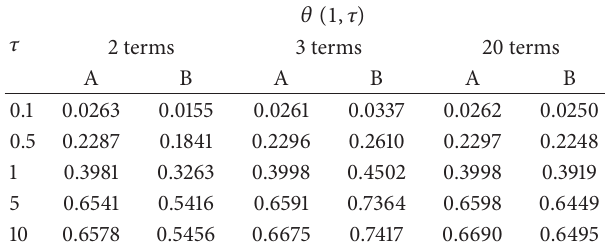
Table 1: Temperatures of the hollow cylinder at outer surface and at